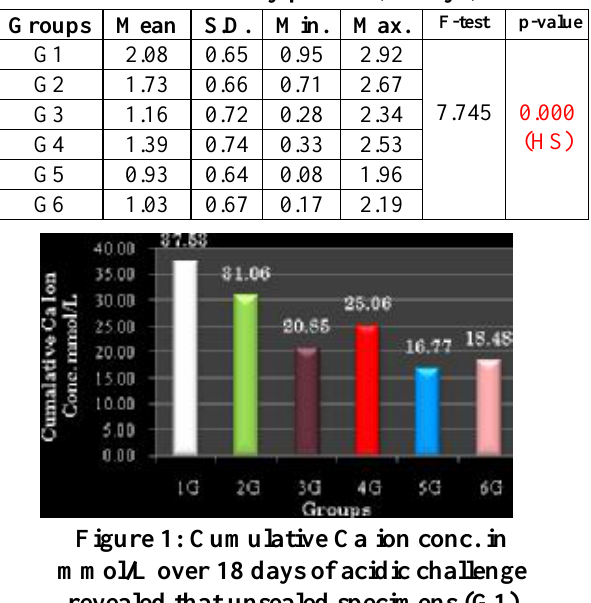
Table 2: Descriptive statistics and groups comparison of the daily Ca ion conc. during the whole study period (18 days).